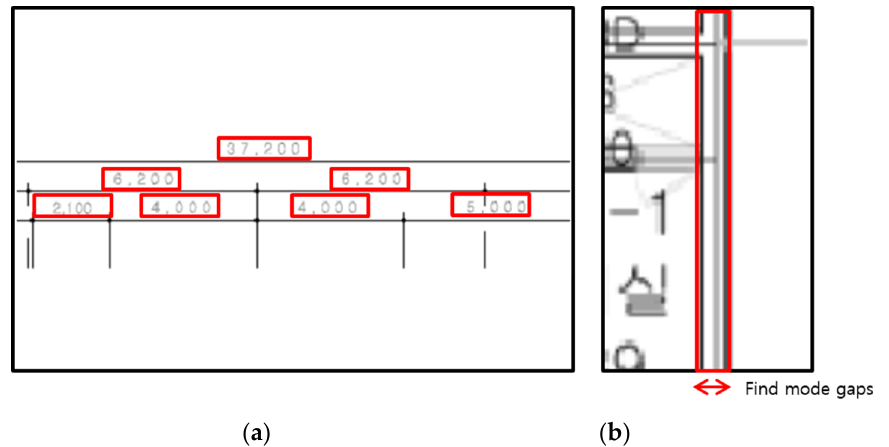
Figure 3. Scale detection algorithm ( a ) utilizing dimension line and ( b ) utilizing and extracting the pixel size.